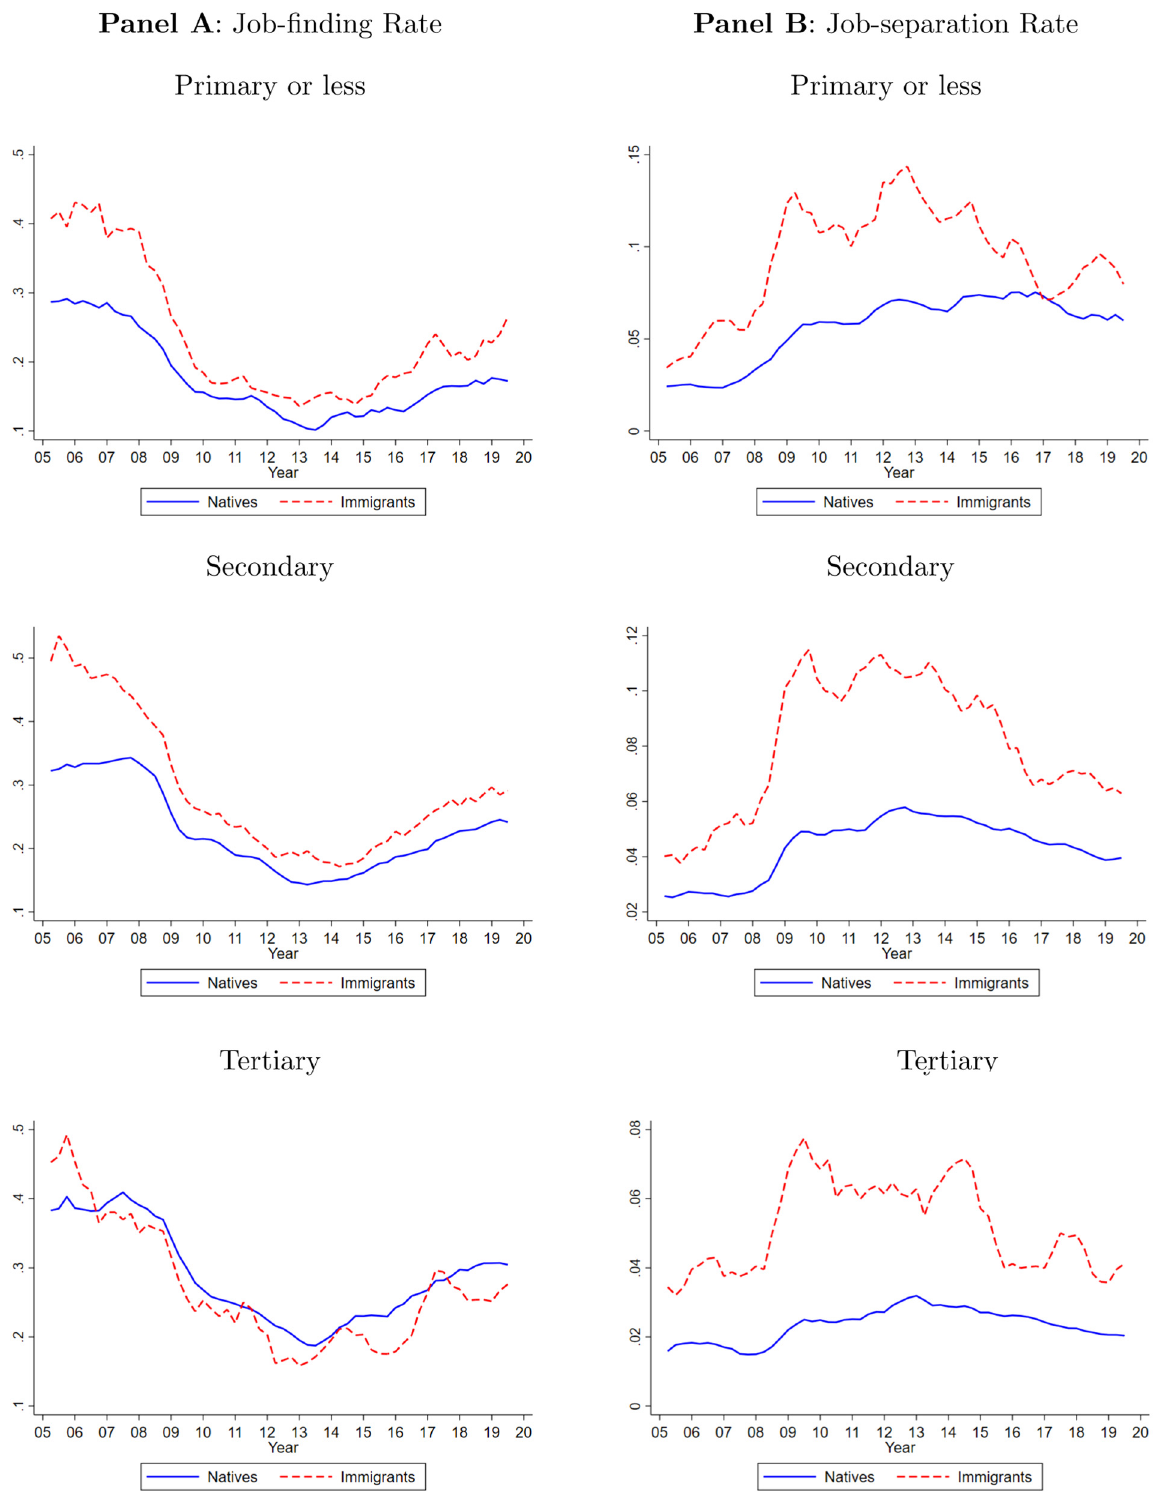
Figure A2: Labour market transitions by nationality and education attainment. ( a ) Job - fi nding rate. ( b ) Job - separation rate. Note: The transitions are seasonally adjusted using a 4 - quarters moving average, constructed from the Spanish Labour Force Survey -